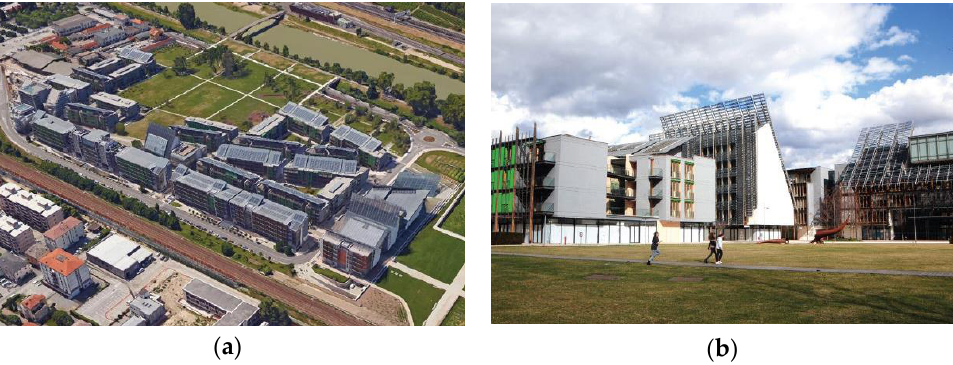
Figure 9. ( a ) Aerial view of the Le Albere district (source: © Google Earth) and ( b ) view from the public park (photo: © Silvia Croce).